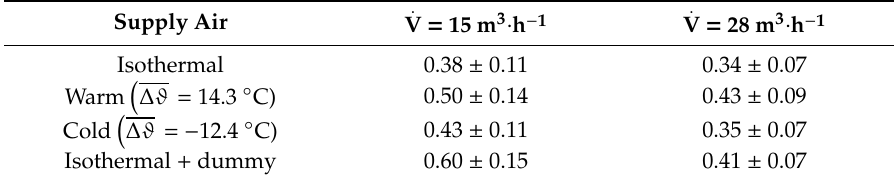
Table 7. Global air exchange e ffi ciencies ε a of various experimental setups. ∆ ϑ is the temperature di ff erence between the outer chamber and the inner chamber at the start of the